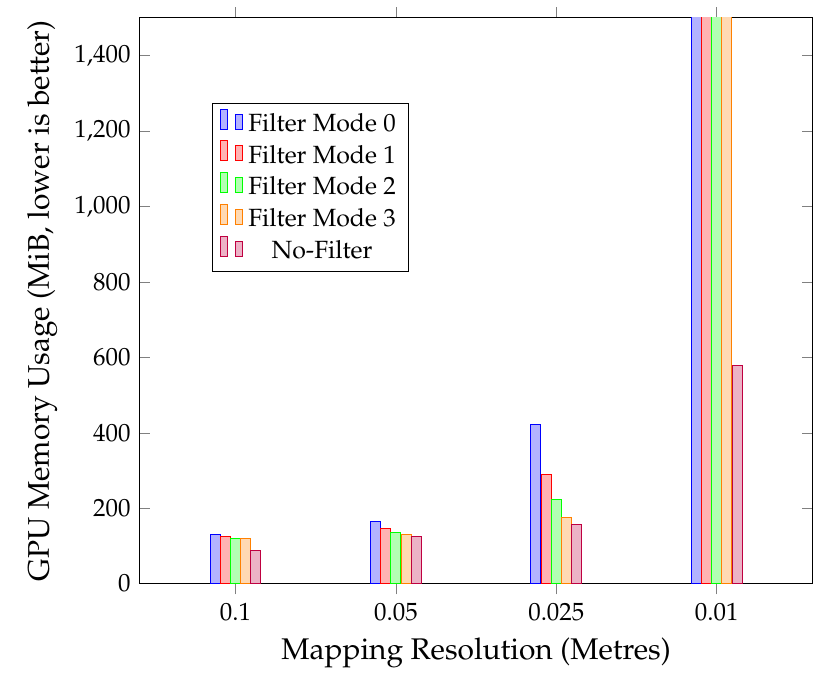
Figure 4. NanoMap GPU memory